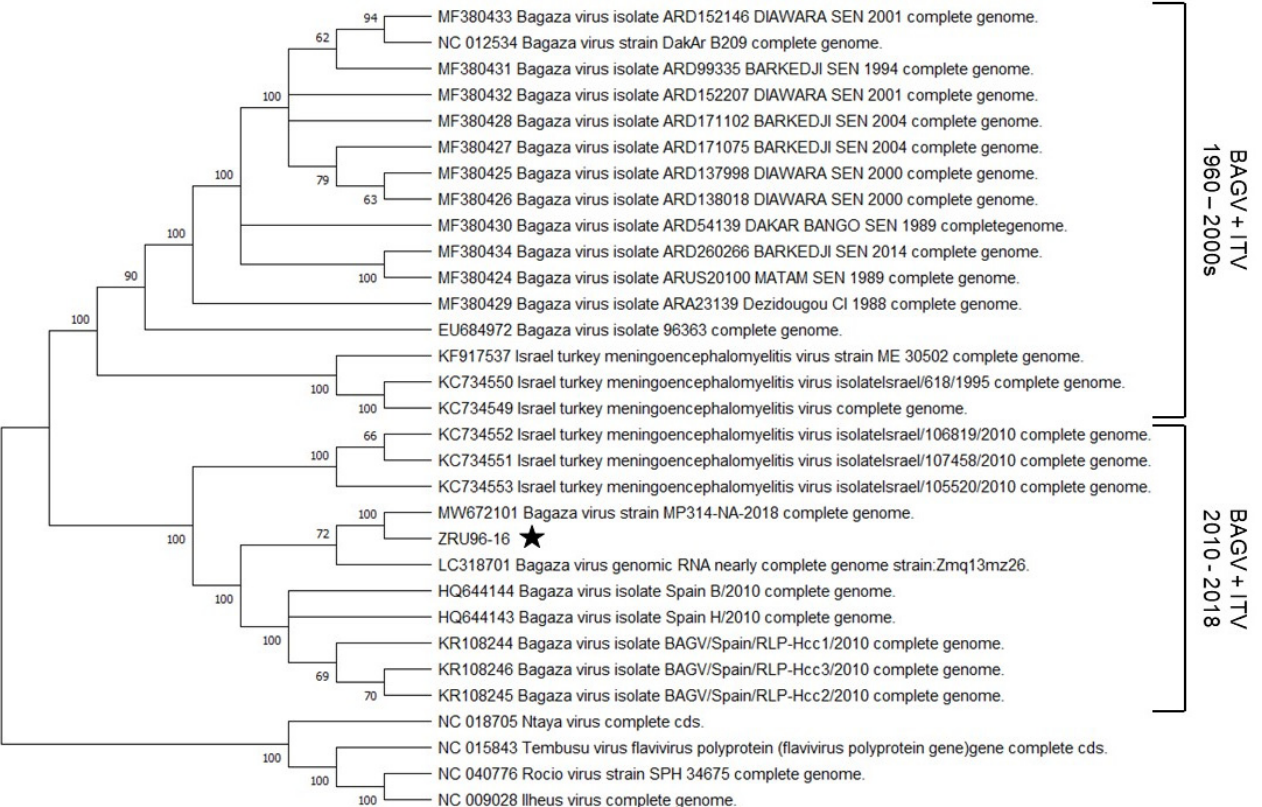
Figure 3. Maximum likelihood phylogenetic analysis of the Ntaya antigenic complex. The maximum likelihood method was used to infer evolutionary relatedness based on the general time reversible model (GTR) in Mega 7. A discrete Gamma distribution was used to model evolutionary rate with invariable rate variation at some sites (G+I). The tree with the highest log likelihood is shown. The tree was rooted on the Ntaya virus branch. Bootstrap support values are represented beside each node as a percentage of. The complete Genbank accession number is illustrated for each virus. The position of ZRU96-16 in the tree is highlighted by a black